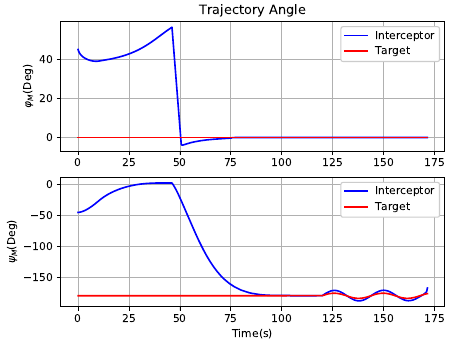
Figure 12. Trajectory angle of interceptor (target maneuvering).